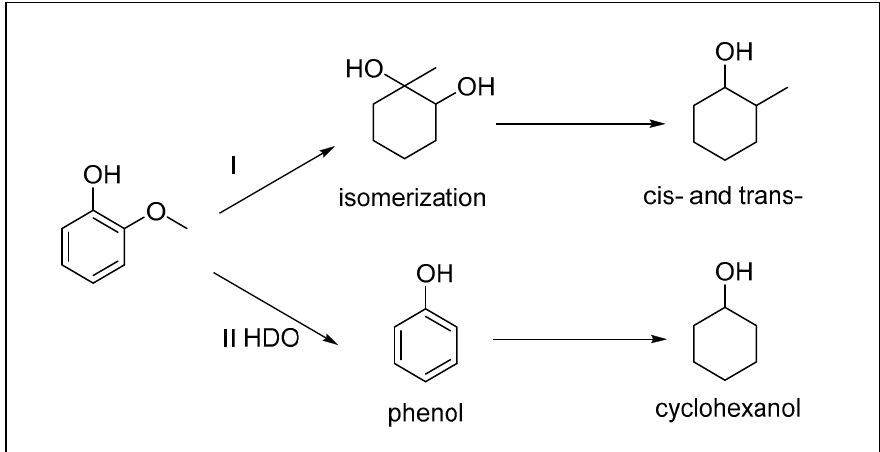
Figure 9. The main pathway of the HDO of guaiacol.